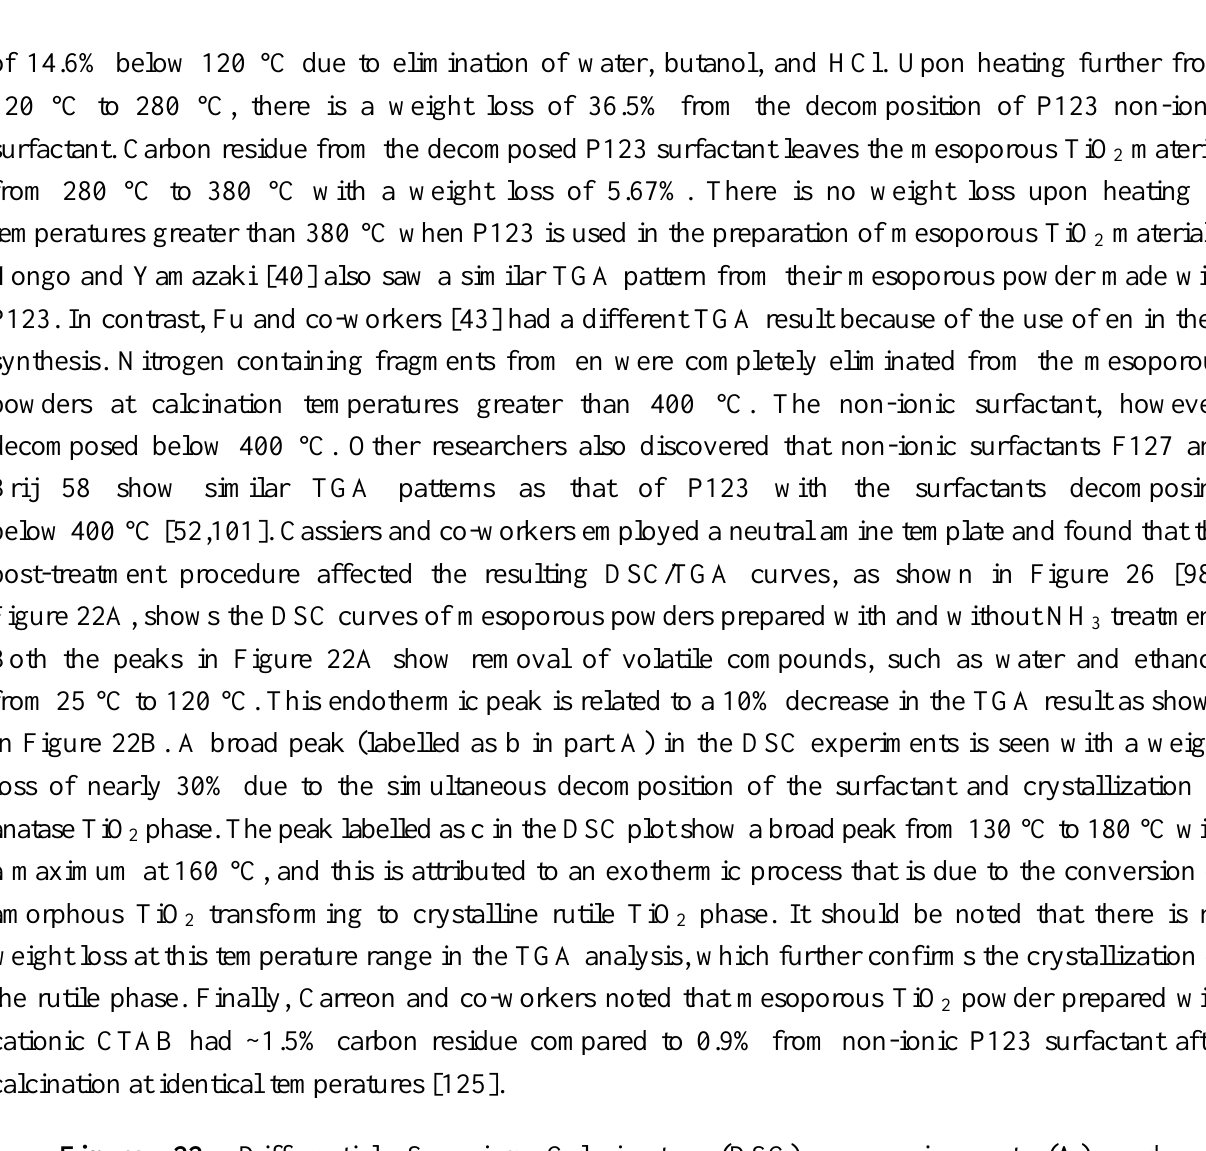
Figure 22. Differential Scanning Calorimetry (DSC) curve in part ( A ) and Thermo-Gravimetric Analysis (TGA) curve in part ( B ) of mesoporous TiO treated with NH . Reprinted with permission from [98]. Copyright 2004 American 3 Chemical